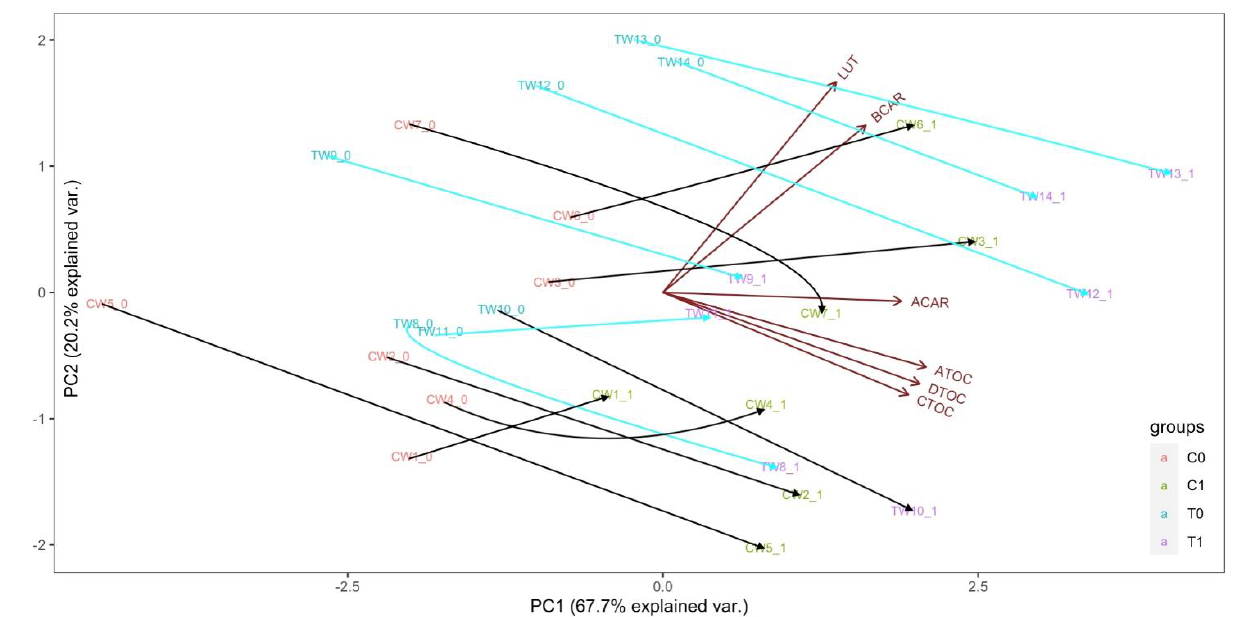
Figure 2. Biplot of 2D−graph of PCA for the 28 winter produced samples. The six variables are projected along with the first two main components, PC1 and PC2, which, in this case, account for 87.9% of the total variability. We chose to highlight with lines the shift of cheese sample coming from the same cow, before (_0 spots) and after (_1 spots) the grazing feeding.